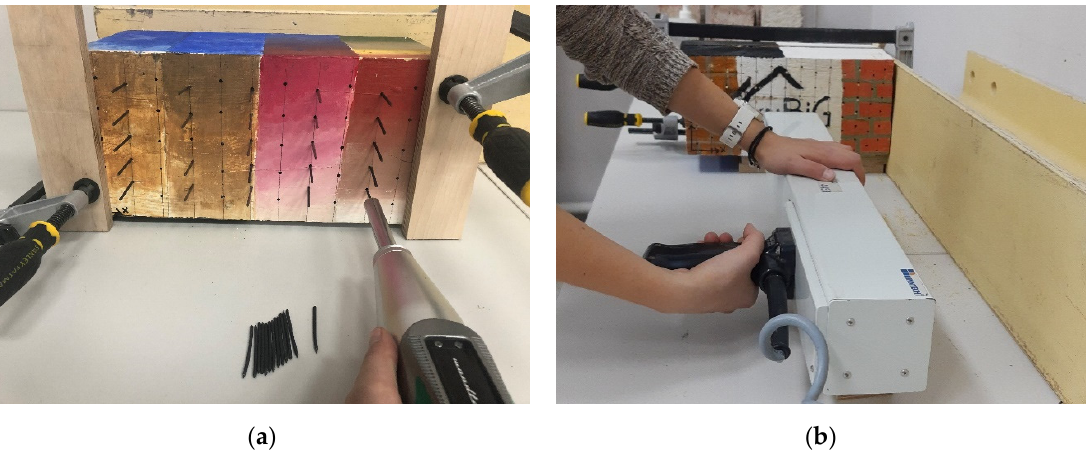
Figure 5. A view of the test stand for semi-destructive methods: ( a ) sclerometric and ( b )